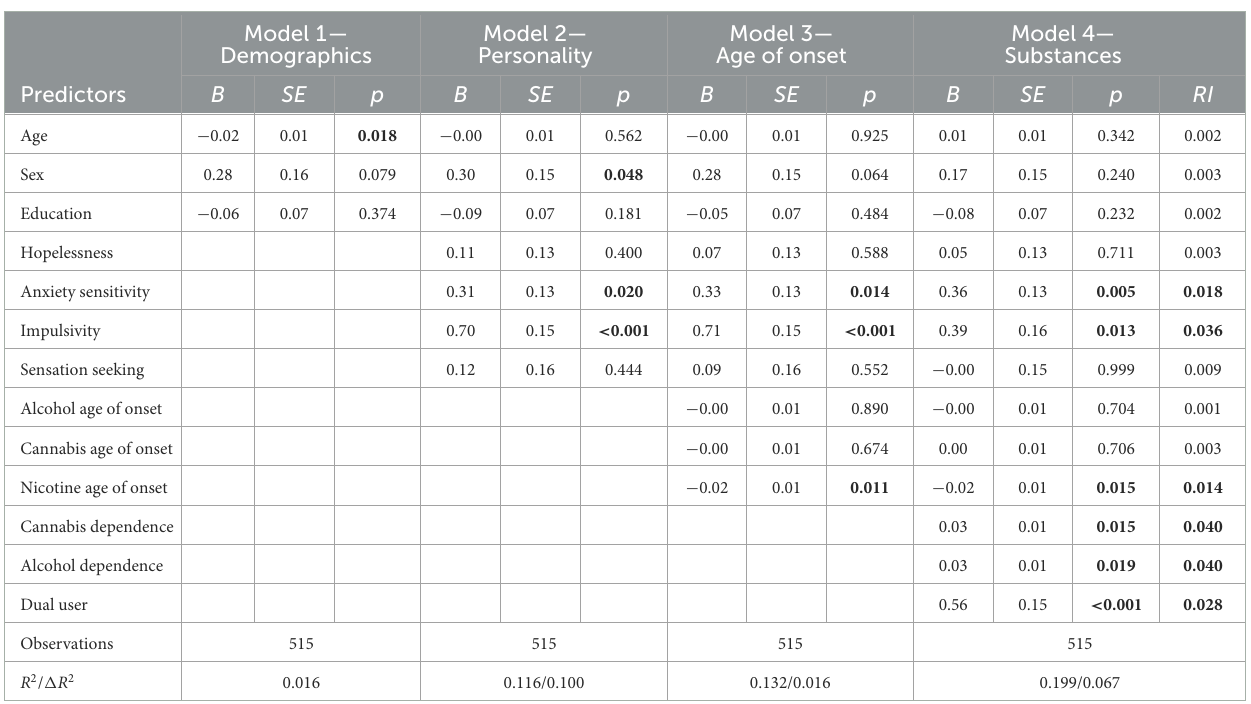
TABLE 3 Hierarchical multiple regression statistics for nicotine